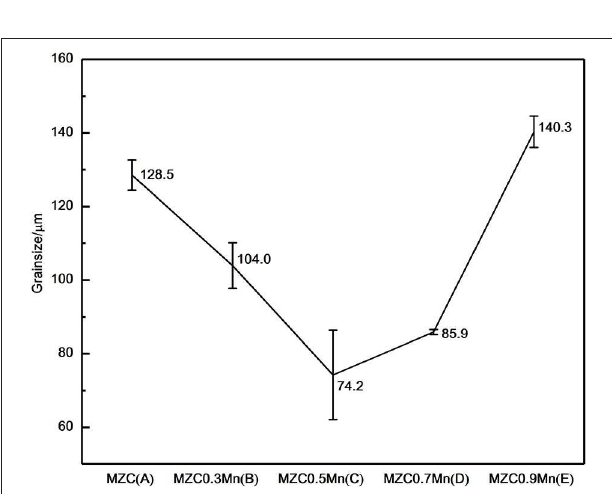
FIGURE 3 | The grain size of as-cast MZC (A) , MZC0.3Mn (B) , MZC0.5Mn (C) , MZC0.7Mn (D) and MZC0.9 Mn (E) alloys.